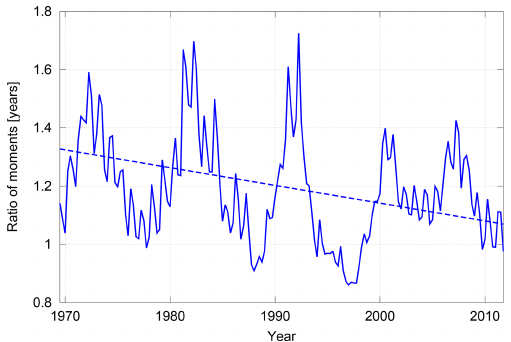
Figure 9. Ratio of moments derived from extended age spectra from the tranPul simulation at 20hPa and 40 ◦